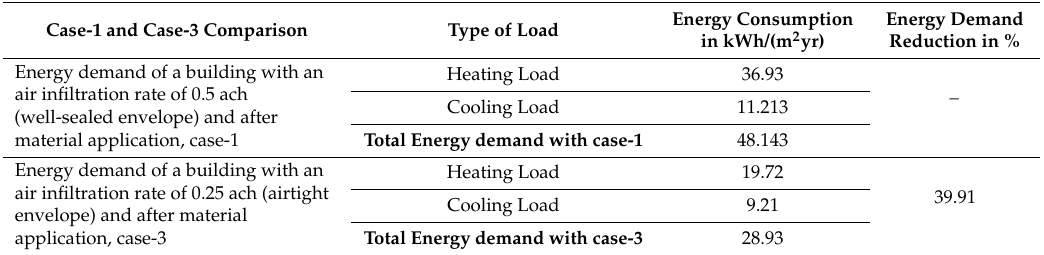
Table 8. Energy demand of a building; comparison of case-1 and